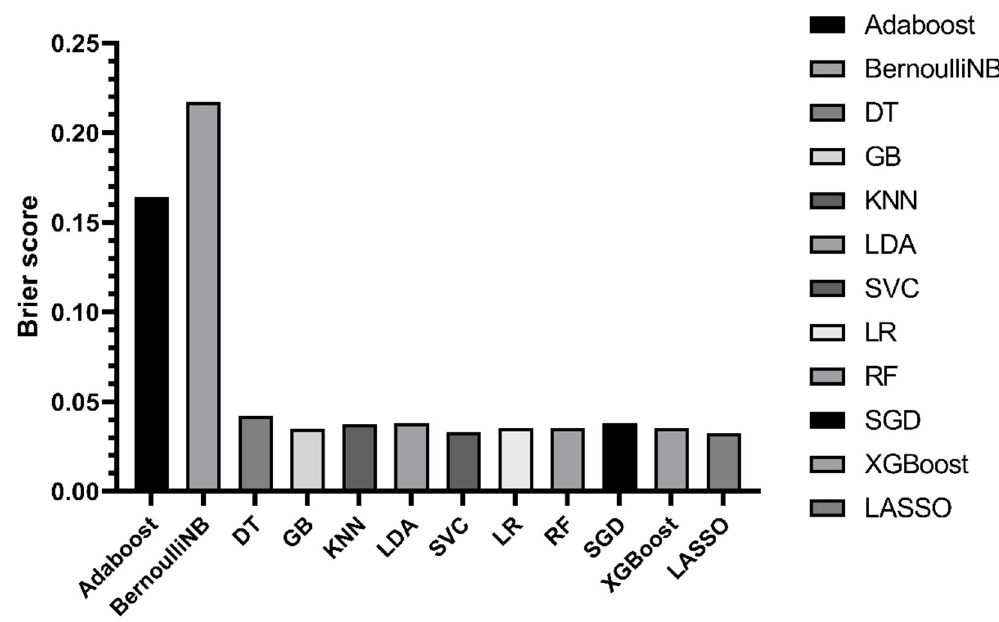
Figure 10. Brier scores of nomogram and ML prediction models in training cohort.